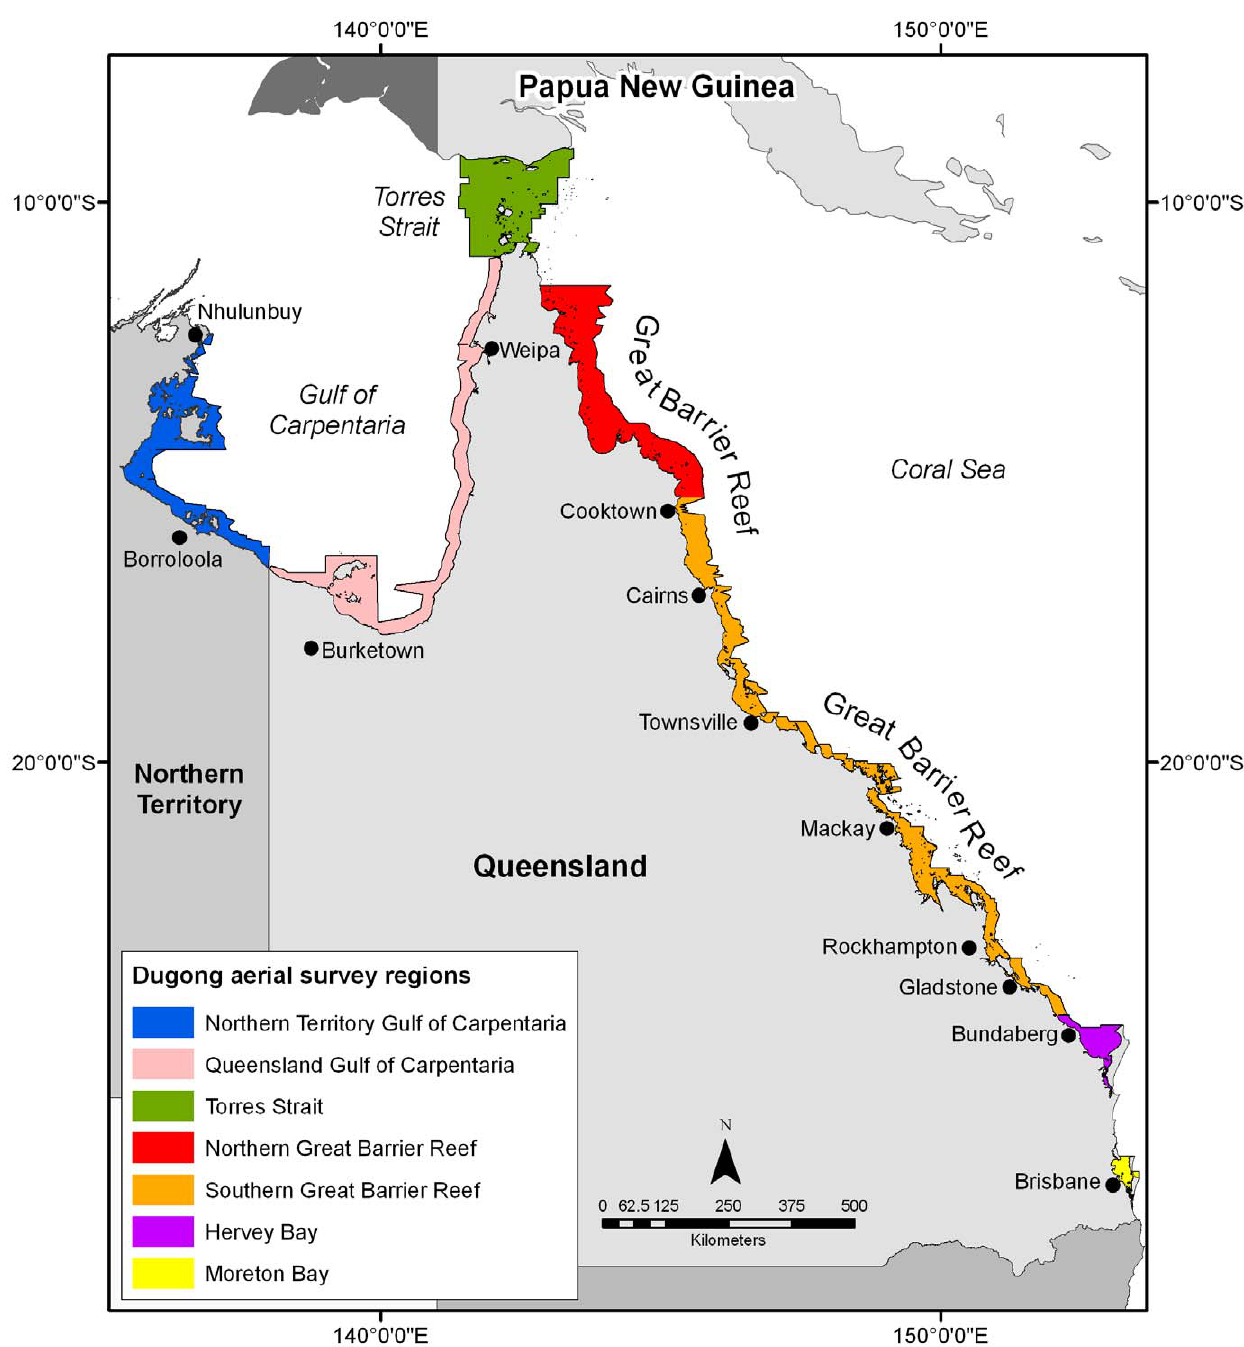
Figure 1. The seven dugong aerial survey regions of northeast Australia. Systematic aerial surveys have been used to monitor the abundance and distribution of dugong populations in northeast Australia since the mid 1980s using strip transect methodology [20]. The outputs of the aerial surveys were used in this paper to develop spatially-explicit models of dugong distribution and relative density in each of the seven survey regions.